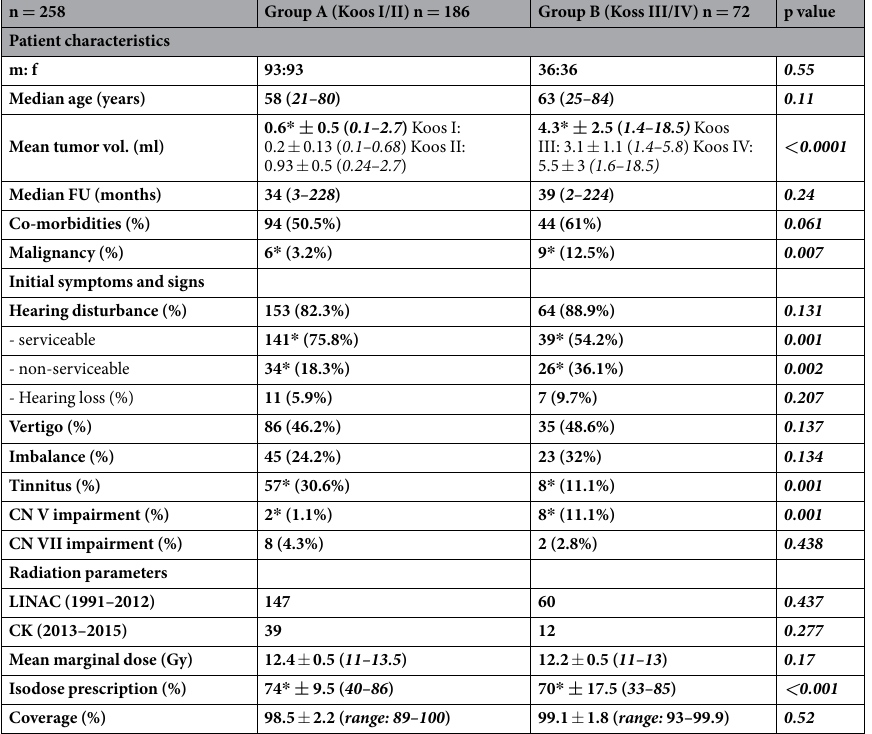
Table 1. Clinical characteristics and treatment parameters of patients. There were statistically significant differences (p < 0.05) between groups if marked with *